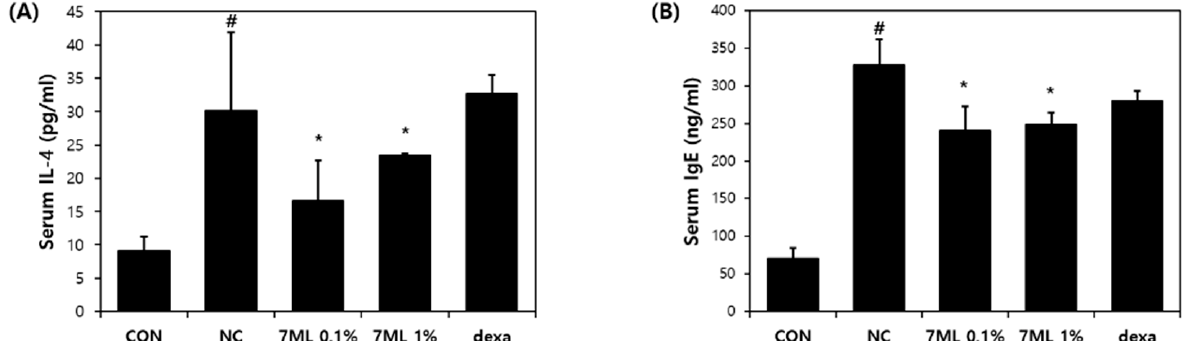
Figure 5. Effects of 7-ML on serum IL-4 and IgE levels in DNCB-induced mice. Serum IL-4 ( A ) and IgE ( B ) levels were measured using an ELISA kit. The results are expressed as means ± SDs ( n = 3). # p < 0.05 vs. nontreated controls; * p < 0.05 vs. DNCB negative controls. CON, nontreated control; NC, DNCB-treated negative control; 0.1% or 1% 7-ML, DNCB + 0.1% or 1% 7-ML-treated groups;